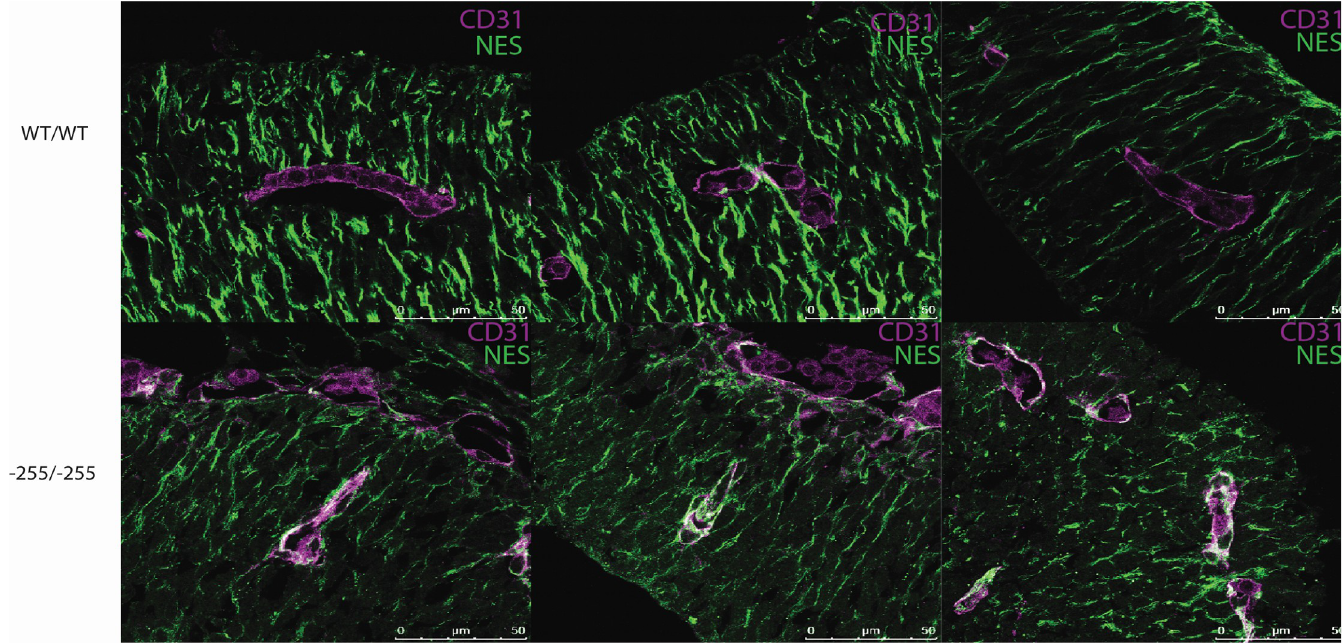
Fig 4. Immunohistochemical analysis of Nestin reactivity within vasculature of 10.5 dpc cortex sections. Confocal microscopy of WT/WT and -255/-255 10.5 dpc cortex sections labelled with NESTIN and CD31 to mark epithelial cells of the vasculature. Co-localisation (white) of Nestin and CD31 is apparent in the -255/-255 sections, and not seen in WT sections. 3 representative blood vessels are shown from a biological replicate for each genotype.